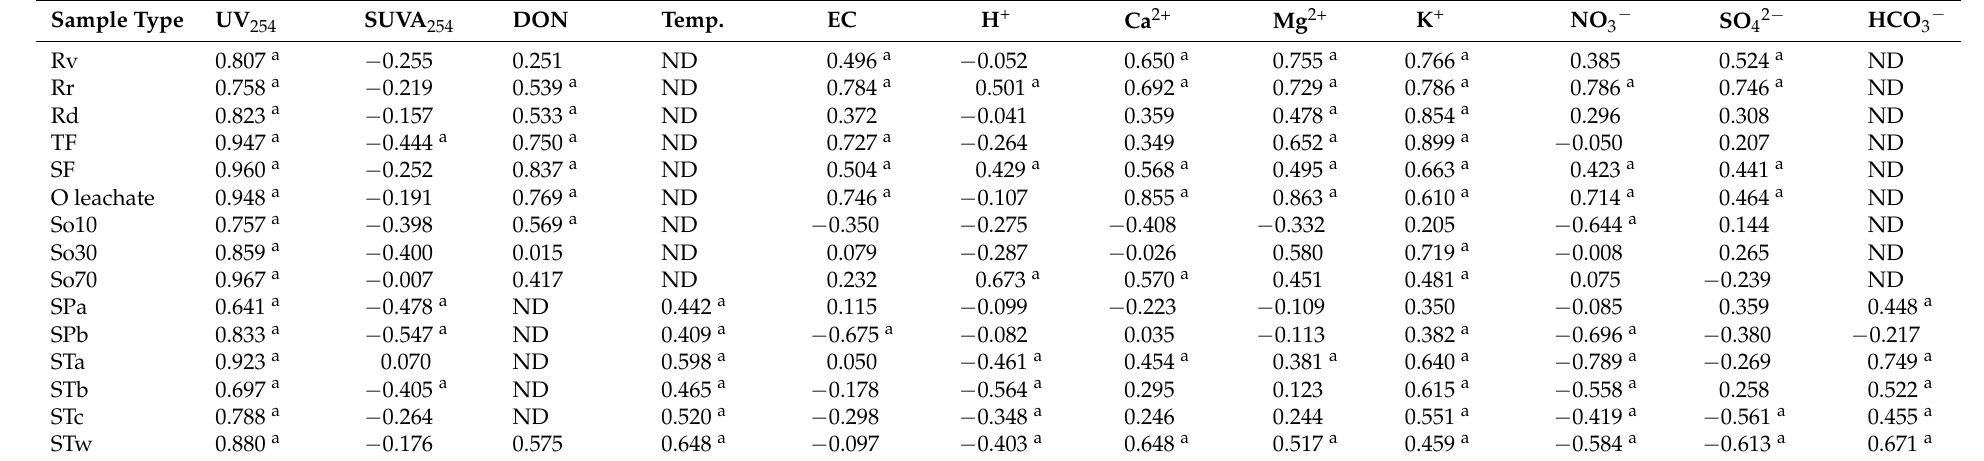
Table 1. Correlations between DOC concentration and other constituents of water samples in the